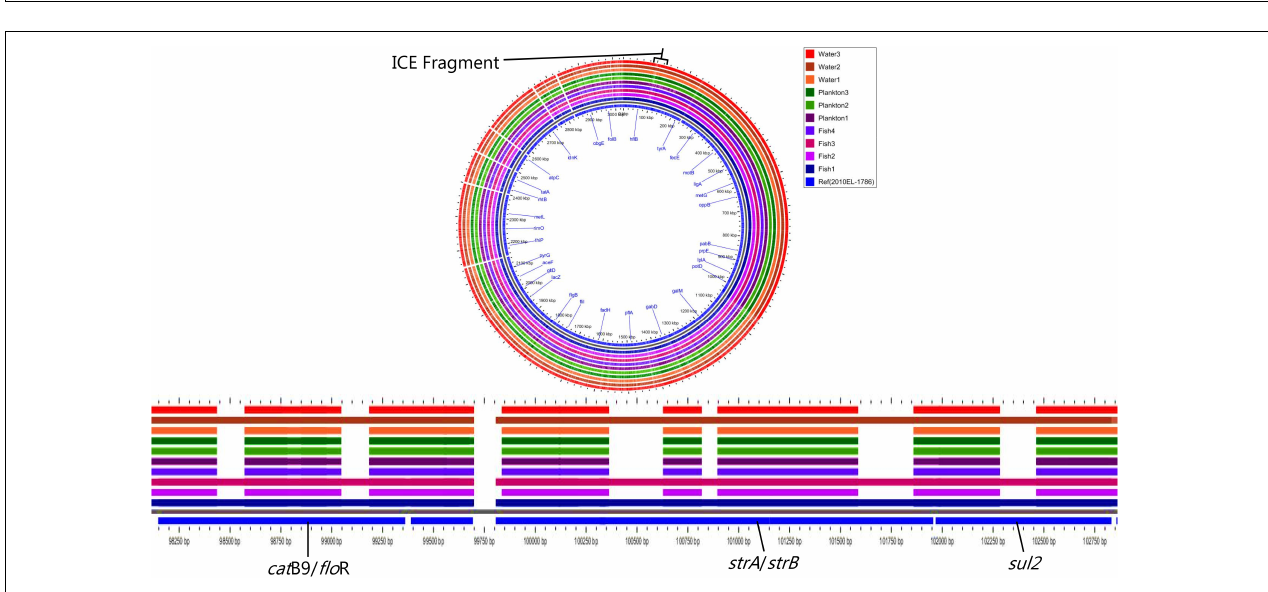
FIGURE 3 | Nucleotide deletions in resistance genes on the ICE